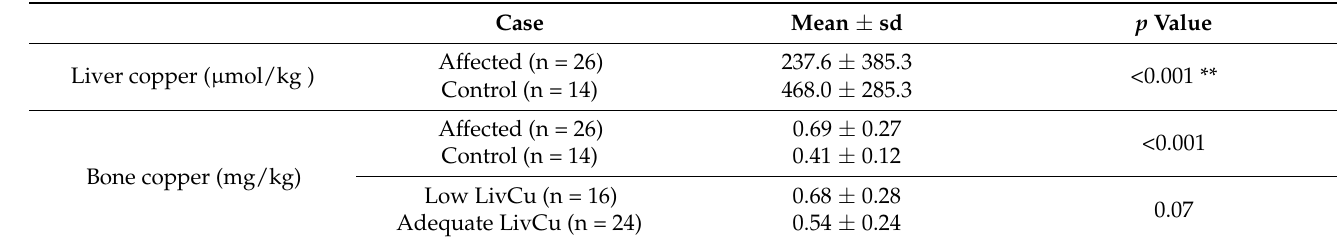
Table 1. Mean ± sd of liver and bone copper concentration in cows comparing humeral fracture status (affected vs. control) and mean ± sd bone copper concentration comparing low vs. adequate liver copper concentration; ** Welch t -test.